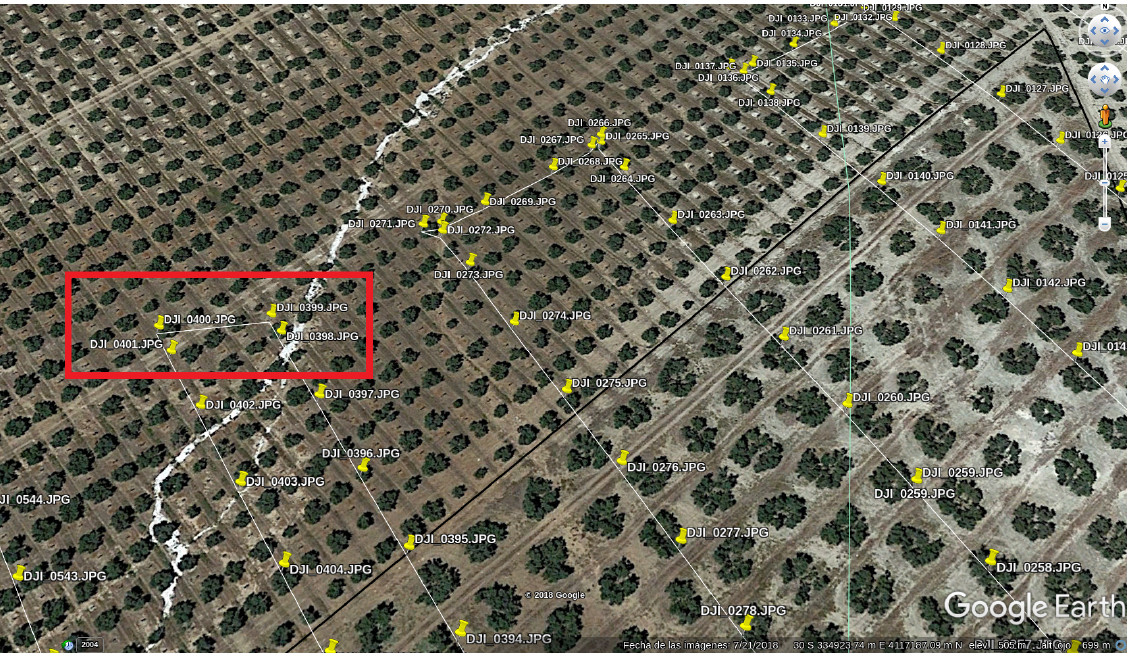
Figure 4. The turn with the insufficient number of